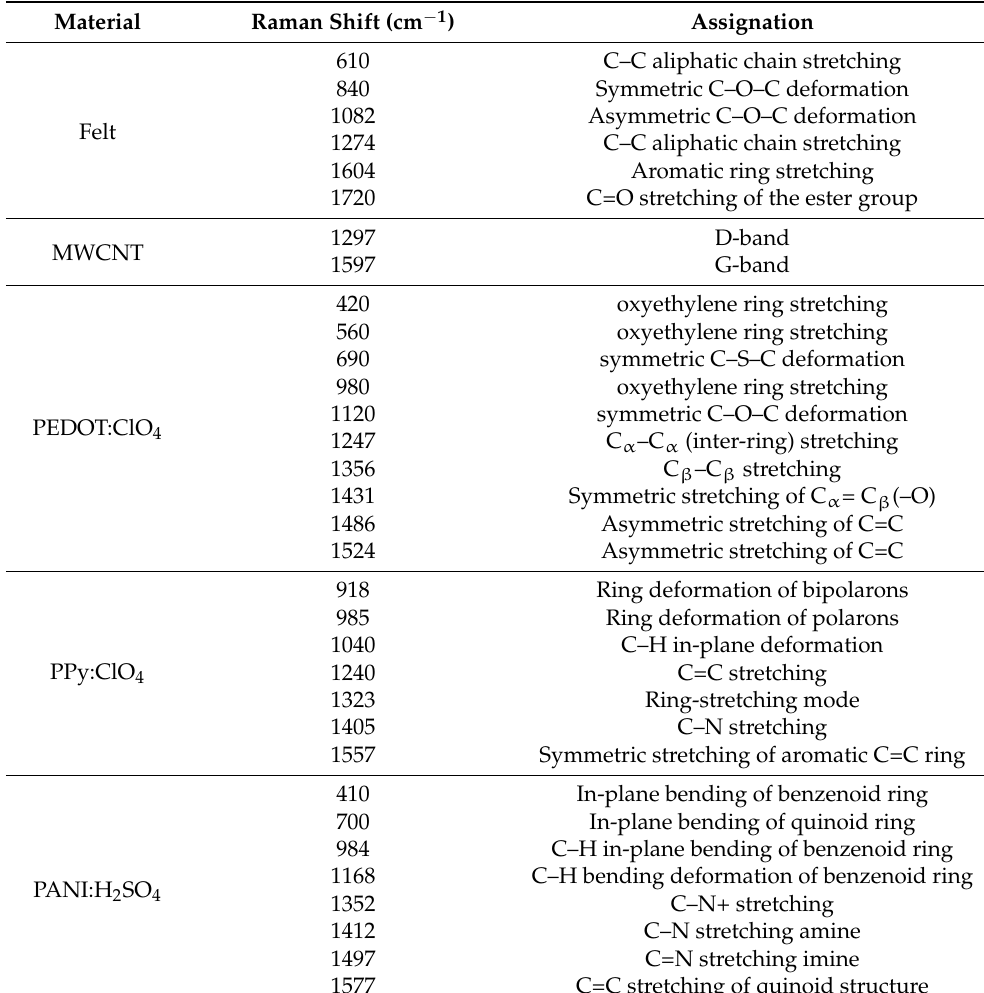
Table 1. Assignation of Raman modes for each